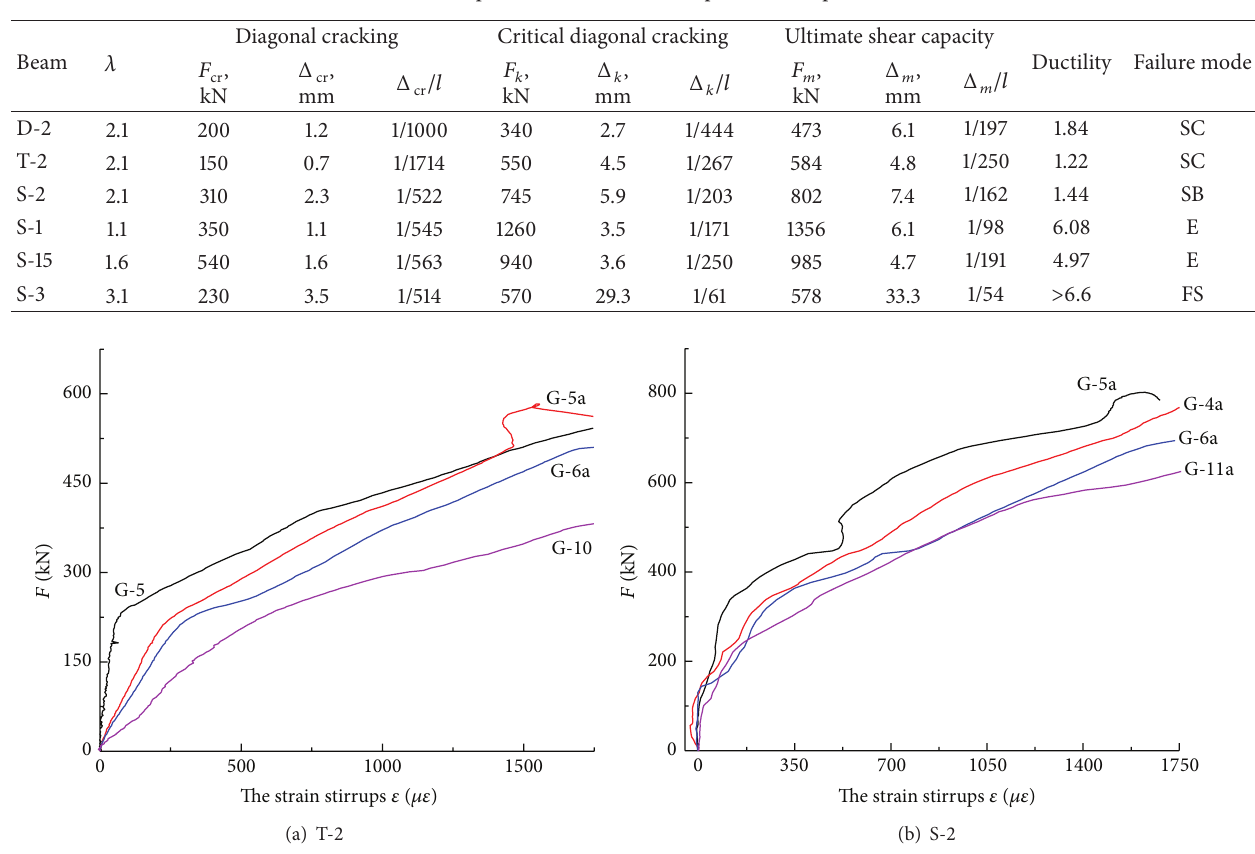
Table 4: Comparisons of characteristic point and displacement.